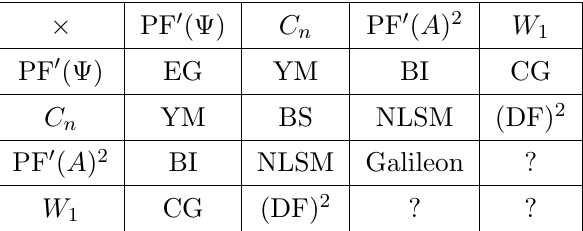
Table 1 . Possible QFTs built out of PF 0 ((cid:9)), C n , PF 0 ( A ) 2 and W 1 . A product is implied between rows and columns, e.g.: I CHY ; EG = PF 0 ((cid:9)) (cid:2) PF 0